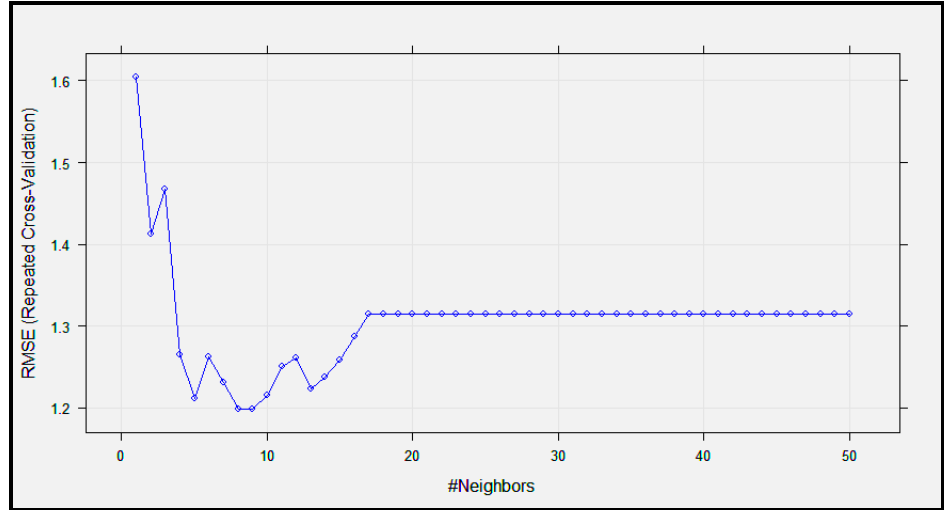
Figure 8. The optimum value of k ‐ numbers for RMSE.